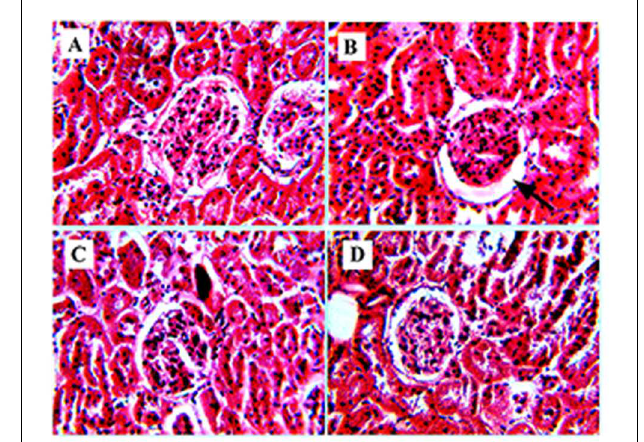
FIGURE 5 | Increase in bowman’s space of kidney. (B) Represents Hematoxylene Eosine staining of STZ induced kidney section, showing wider bowman’s space (represented by arrow). (A) Represents normal kidney with glomerulus. (C) It is the RE (100 mg/kg) treated kidney, represents improvement in the glomerular structure and (D) represents glibenclamide (10 mg/kg) treated kidney section, showing restoration of the bowman’s space of